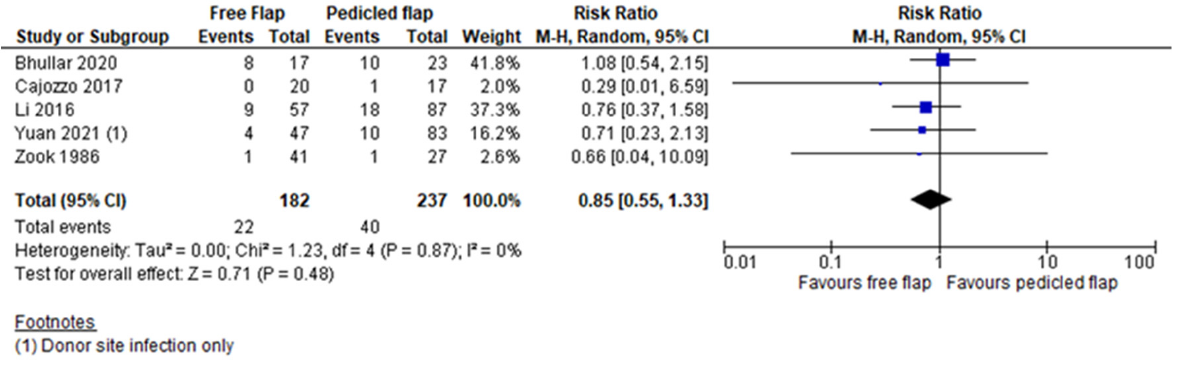
Figure 7. Post-operative wound infection meta-analysis [13,18–21]. Table 4. Leave-one-out sensitivity test.